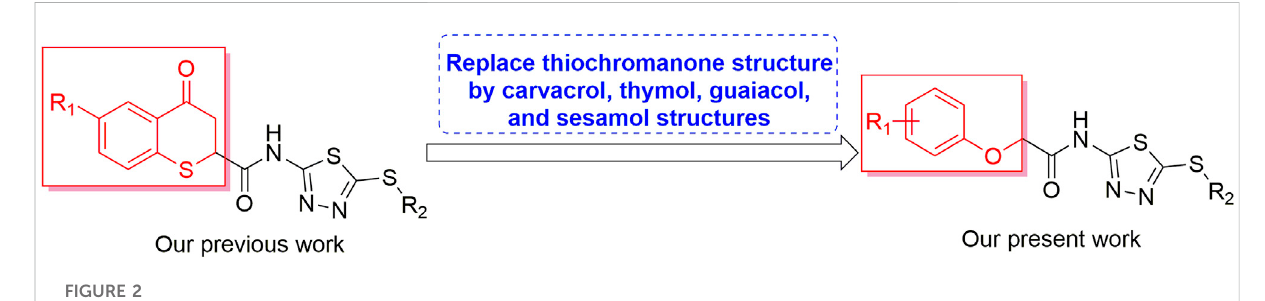
FIGURE 2 Design route of the target compounds 5a −